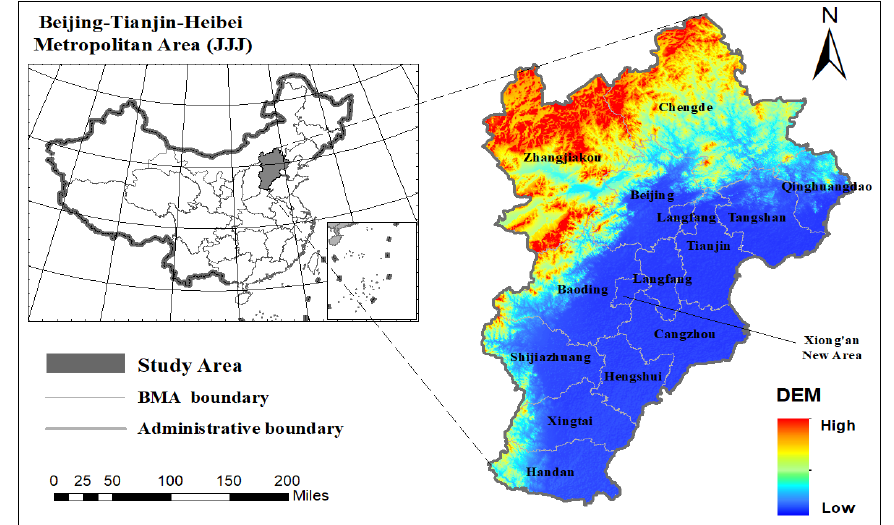
Figure 1. Study area (Beijing-Tianjin-Hebei Metropolitan Area, JJJ).